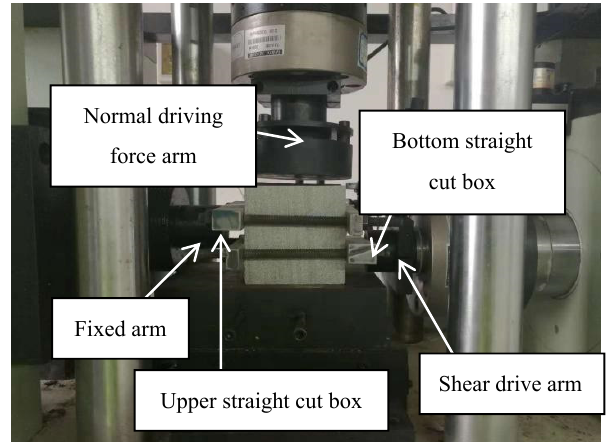
Figure 3. Shear loading on a rock sample.